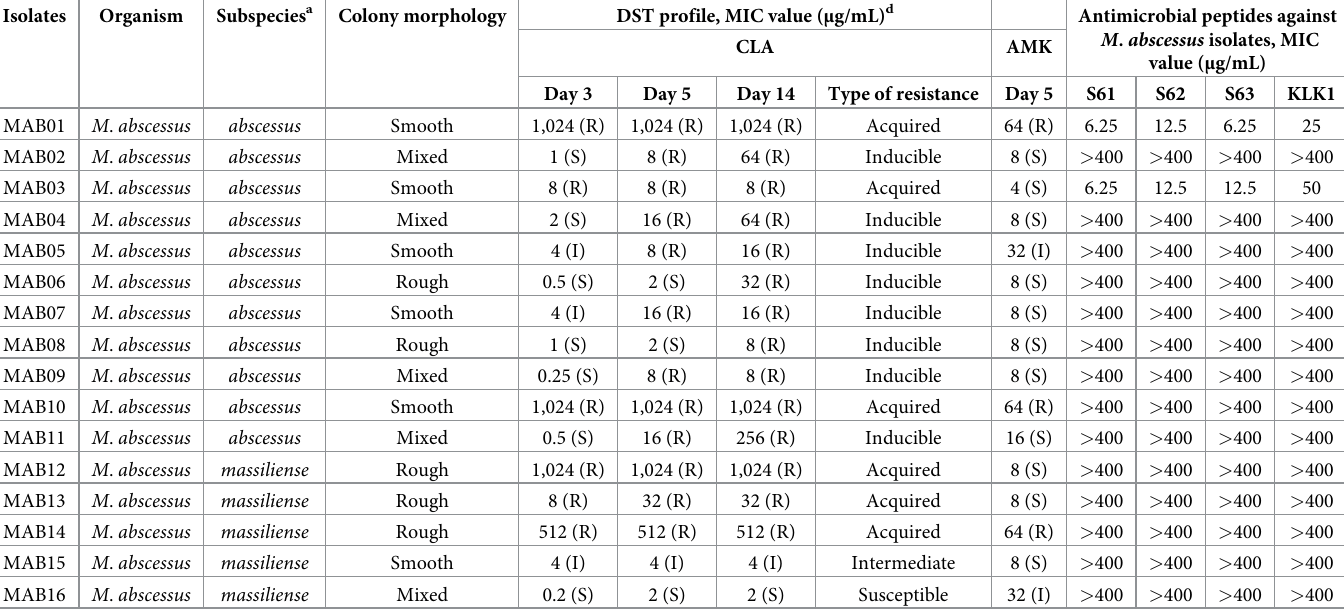
Table 2. Characteristics and in vitro antibacterial activities of four potential AMPs against 16 clinical isolates of M . abscessus .